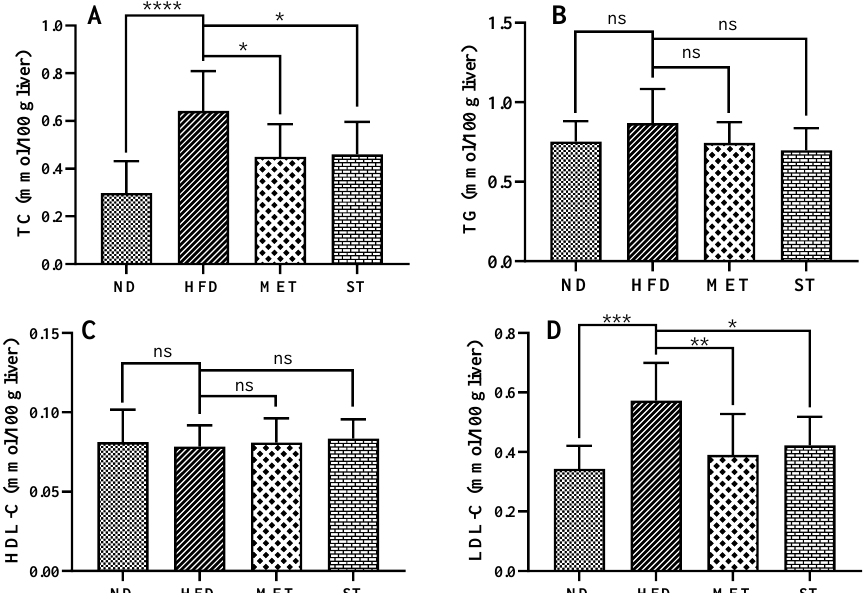
Figure 4. Effects of methanol extract of fermented green tea and spore suspension on TC ( A ), TG ( B ), HDL-C ( C ), LDL-C ( D ) levels in the liver of hamsters for 2 consecutive weeks of intervention. Statistical significance of differences between groups was determined using Ordinary one-way ANOVA. Data are expressed as mean ± SD ( n = 10). * p ≤ 0.05; ** p ≤ 0.01; *** p ≤ 0.001; and **** p ≤ 0.0001. “ns” indicates not significant ( p > 0.05).